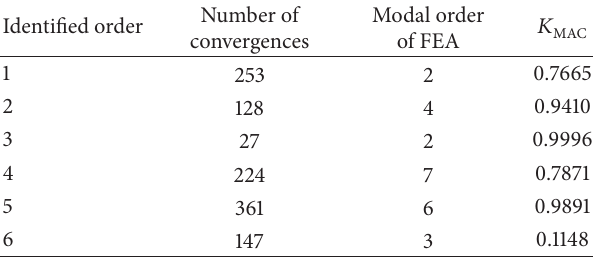
Table 16: The convergence times and MAC value of modal shapes when observed signals are with measurement